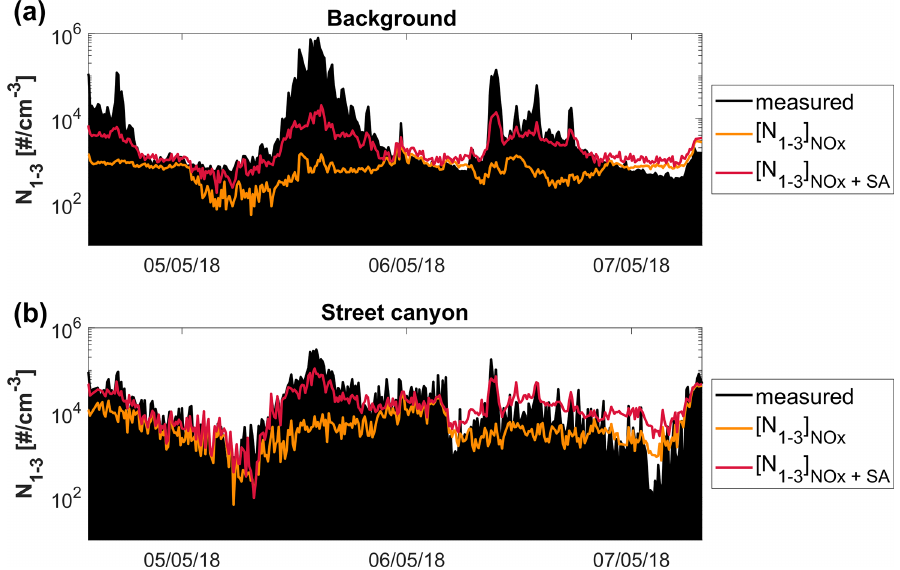
Figure 10. The time series of sub-3nm particle concentration measured during 5 May 00:00LT–7 May 00:00LT (black) and estimated based on NO x concentration (orange) and NO x and SA concentrations (red) (a) at the background station and (b) at the street canyon